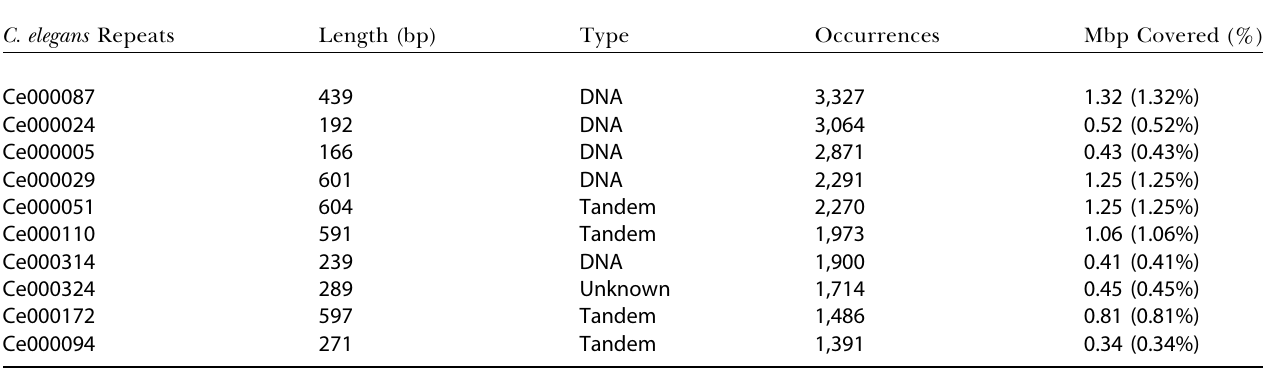
Table 7. Top Ten Most Abundant Repeat Element Families in C. elegans C. elegans